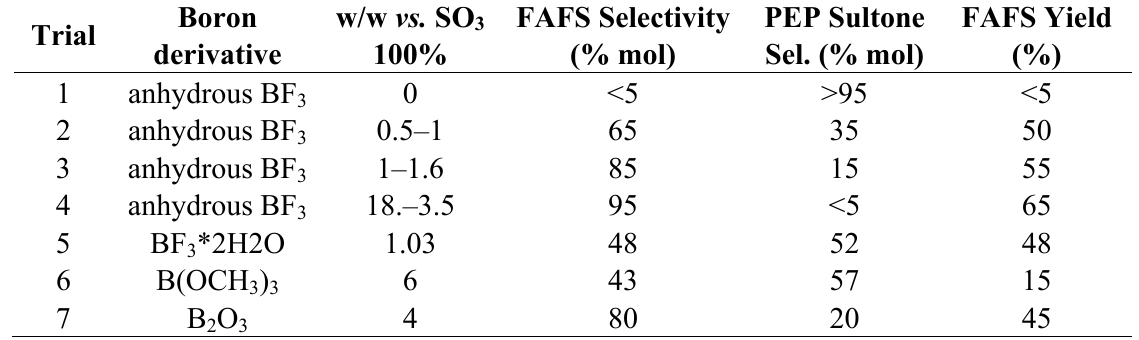
Table 2. FAFS/HFP sultone molar selectivity as a function of [SO